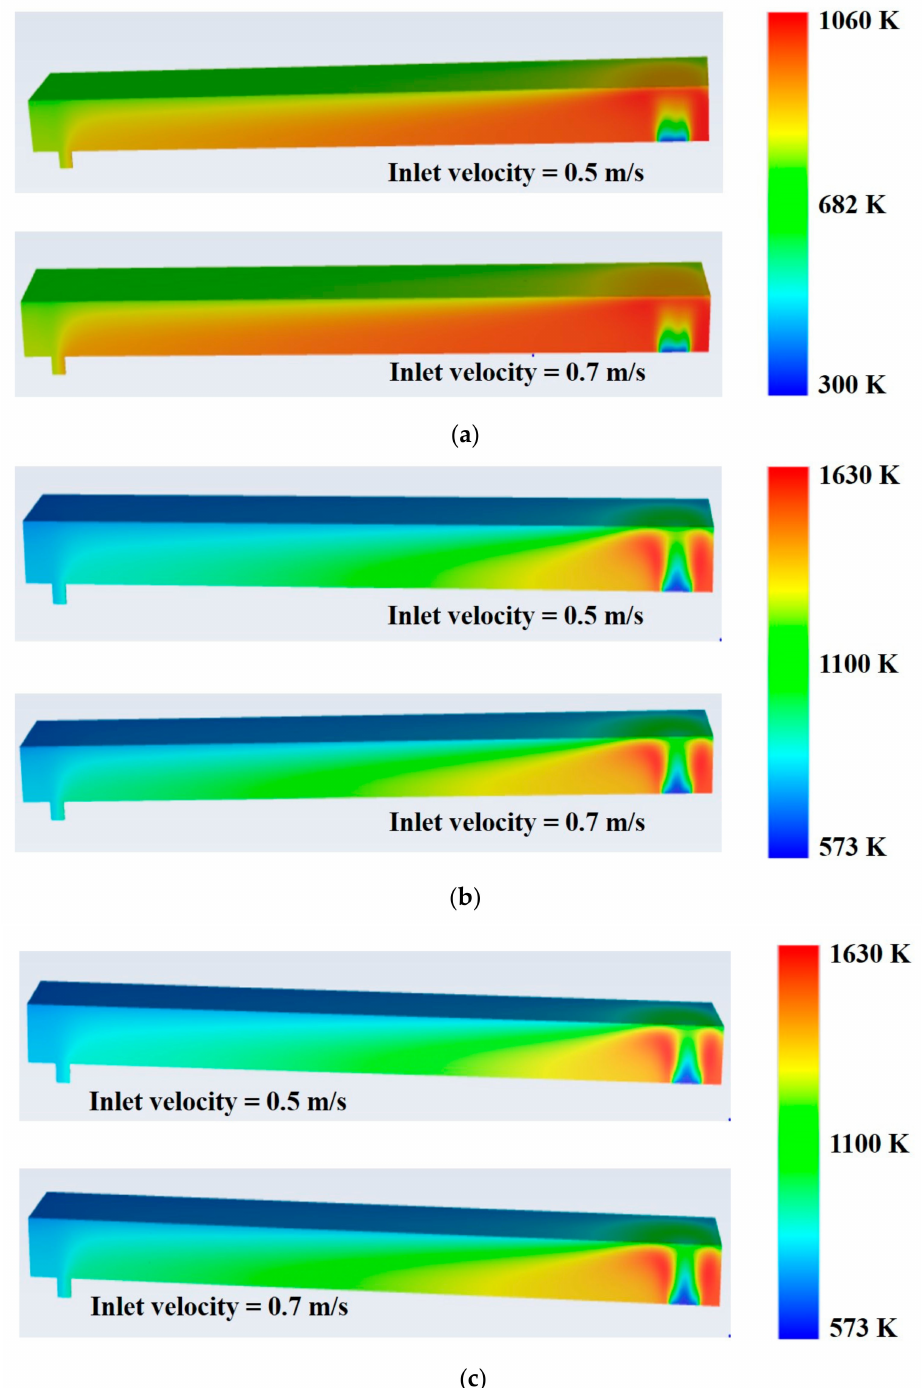
Figure 5. Temperature contours: ( a ) case I; ( b ) case II; and ( c ) case III at di ff erent inlet